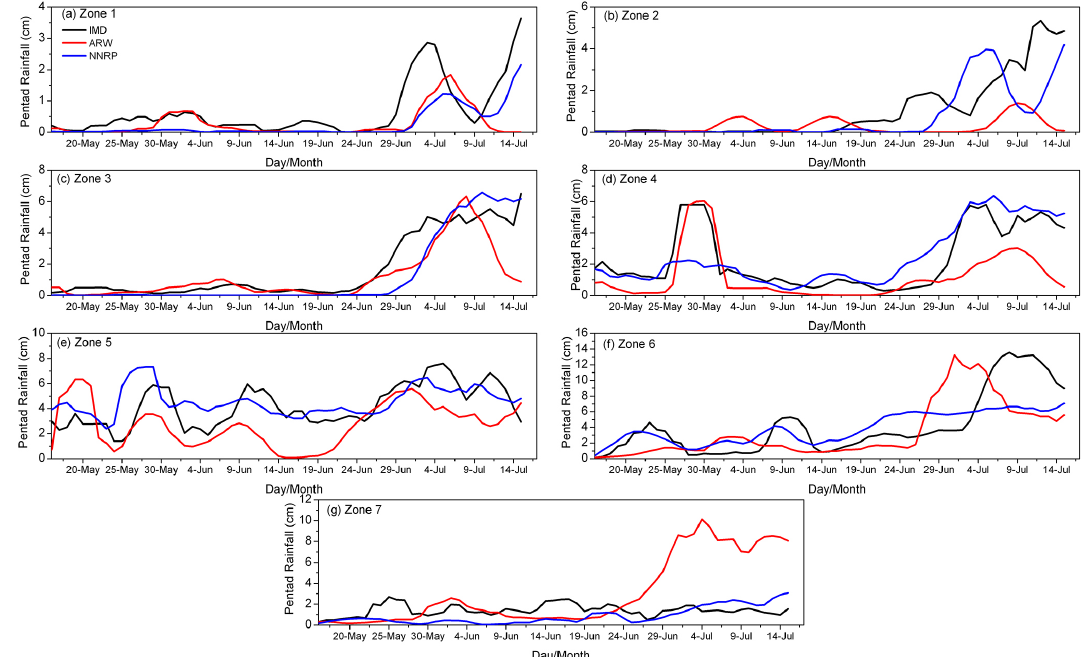
Figure 4. Time series of running pentad rainfall (cm) averaged over different rainfall zones in the period 12 May–30 June 2009, along with corresponding pentad rainfall derived from NNRP reanalysis and IMD 50km gridded rainfall data. The first pentad is 12–16 May, the second pentad is 13–17 May...and the last pentad is 26 June–30 June. Panels (a) to (g) correspond to zone 1 to zone